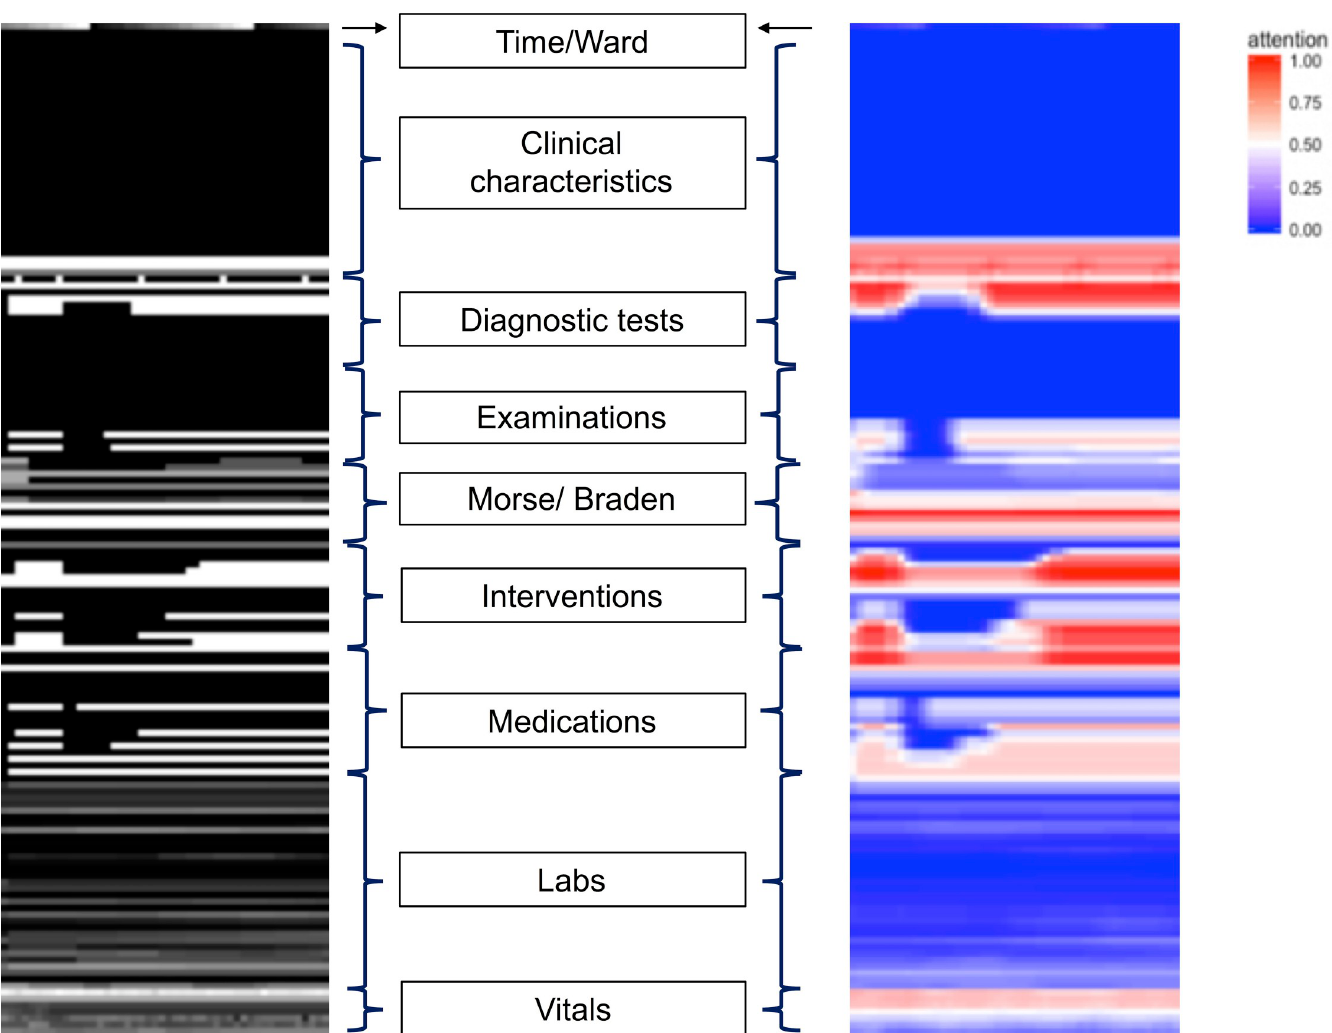
Fig 3. Original (left) and Grad-CAM attention-based heatmap (right) derived for the CNN-RL model for a min-max normalized standard ordering visual timeline of a test patient who died in-hospital. As can be seen, the area of interventions and diagnostic testing have been highlighted as the most contributing areas for predicting a high probability of mortality for this